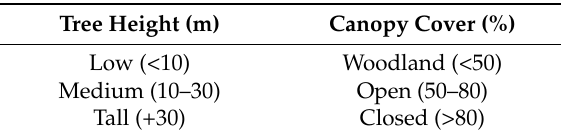
Table 1. Native forest structural classes in